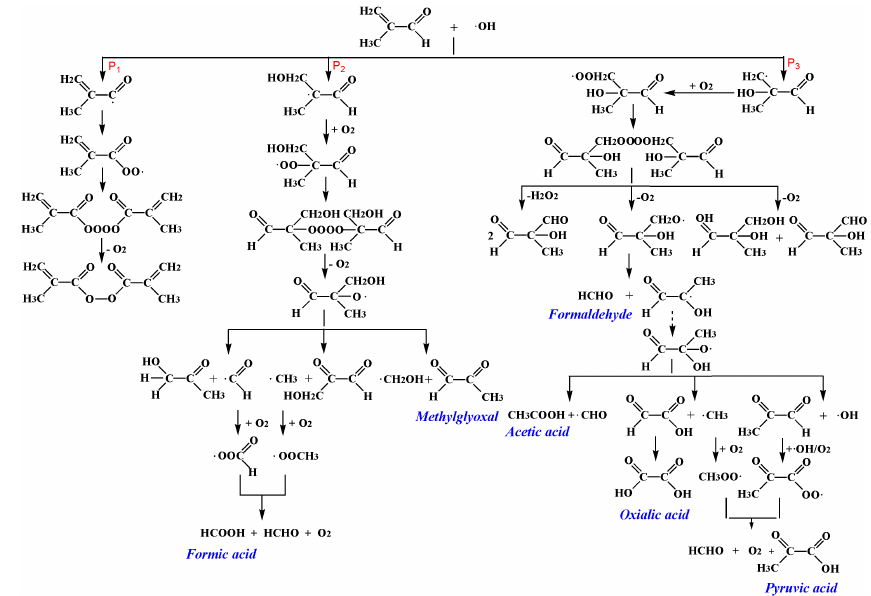
Fig. 4. Scheme for the tentatively proposed reaction pathways leading to the observed products from the MACR–OH reaction.